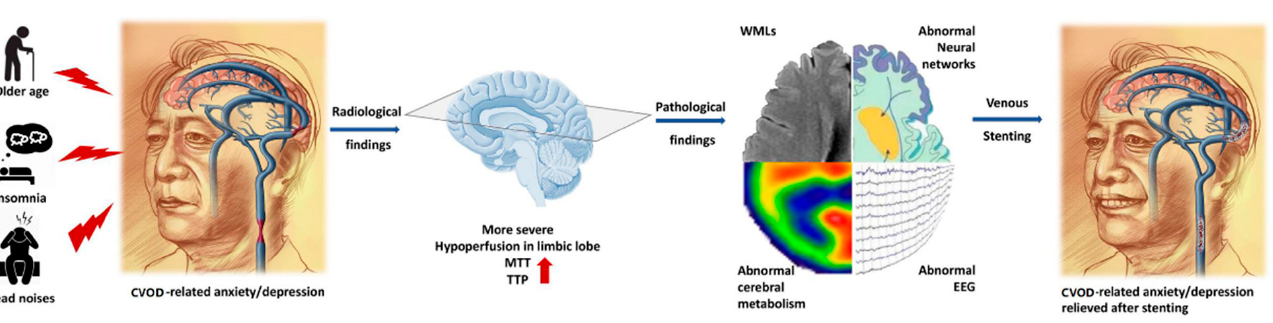
Figure 5. Probable mechanisms leading to anxiety and depression in CVOD patients.